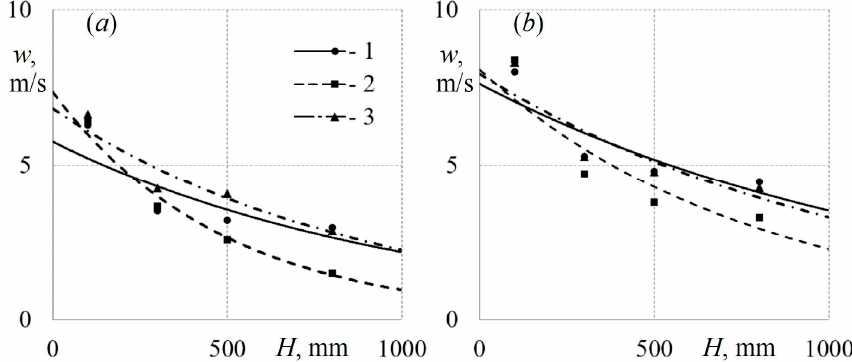
Figure 9. Dependences of the average air flow rate w along the installation height H when air is supplied through round (1), square (2), and triangular (3) tubes for the initial average flow rate in the first section: ( a )— w 1 ≈ 6.5 m/s; ( b )— w 1 ≈ 8.25 m/s.